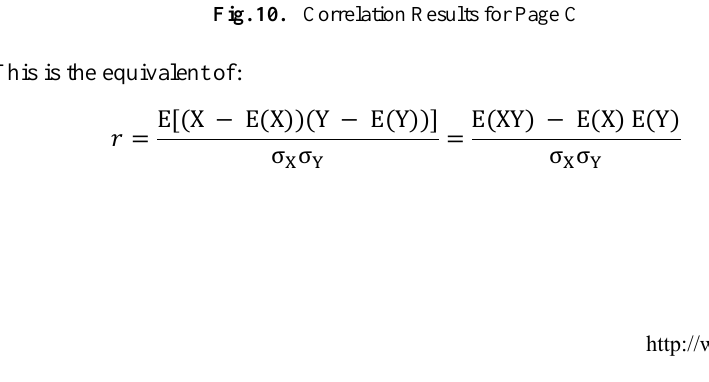
Fig. 10. Correlation Results for Page